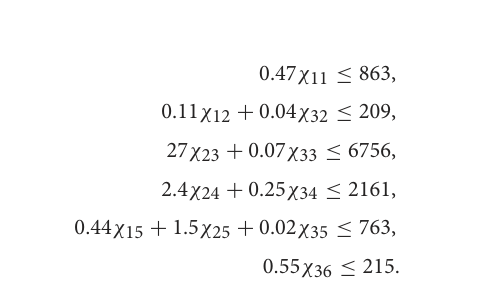
Table 2 are needed. The six consumers create the six constraints as